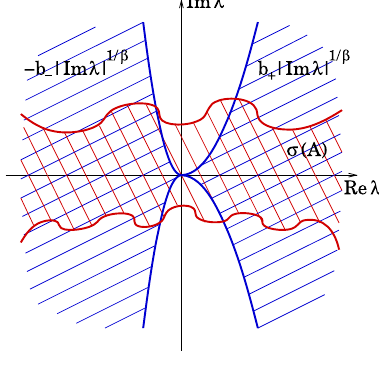
Figure 1: Gevrey ultradi ff erentiability of order β 1 ∞ ≤